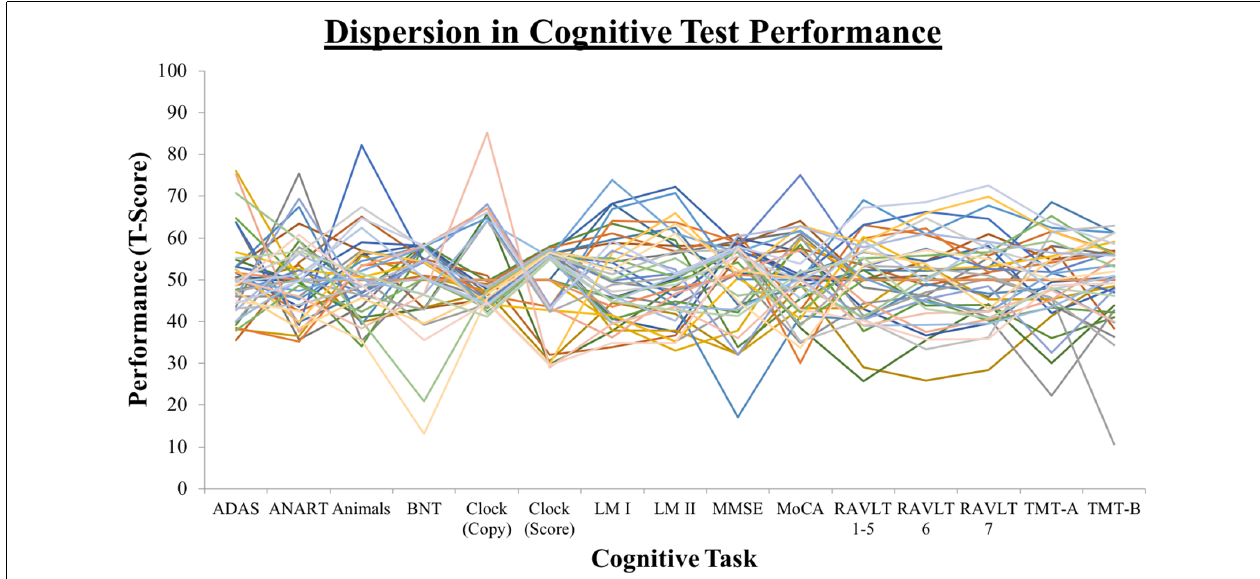
FIGURE 1 | Dispersion profiles depicting the overall magnitude of variability across the cognitive testing